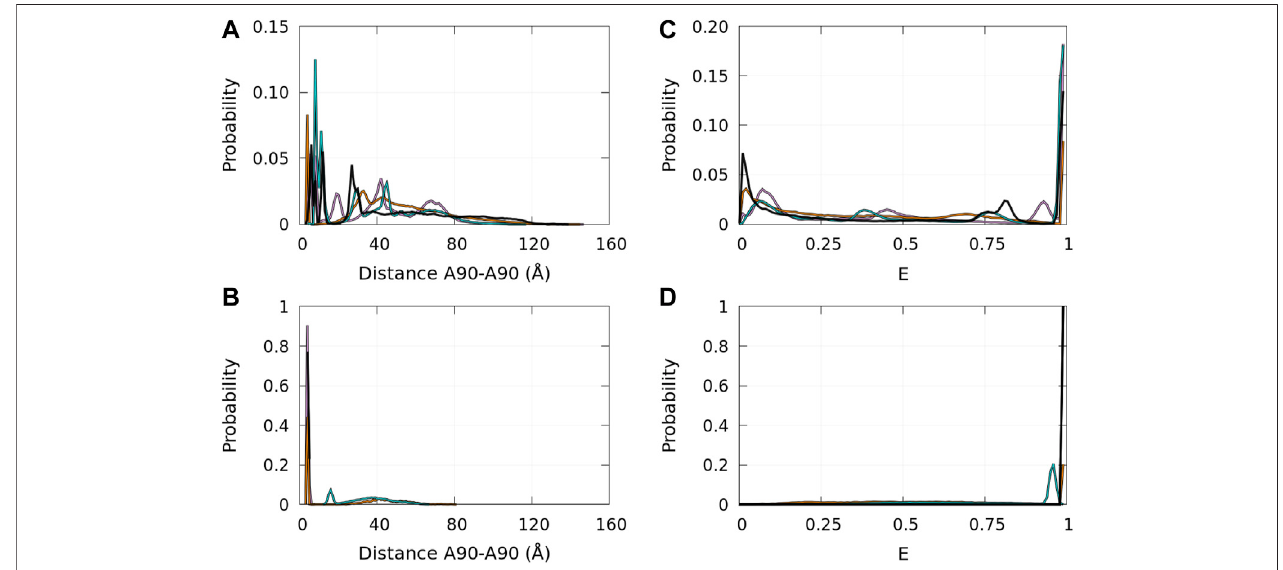
FIGURE 11 | Probability density functions of the distance between the C α atoms of residues A90 in the ensembles of disordered dimers [panel (A) ] and of Dfncs [panel (B) ] and the corresponding probability distribution functions of the approximated FRET ef fi ciency E (see text) for the ensembles of disordered dimers [panel (C) ] and of Dfncs [panel (D)] . Color code: WT — black, A30P — purple, E46K — turquoise, and A53T —